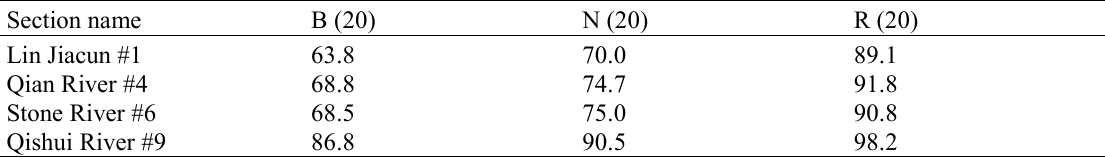
Table 6 Monthly guarantee rate of minimal eco-flow